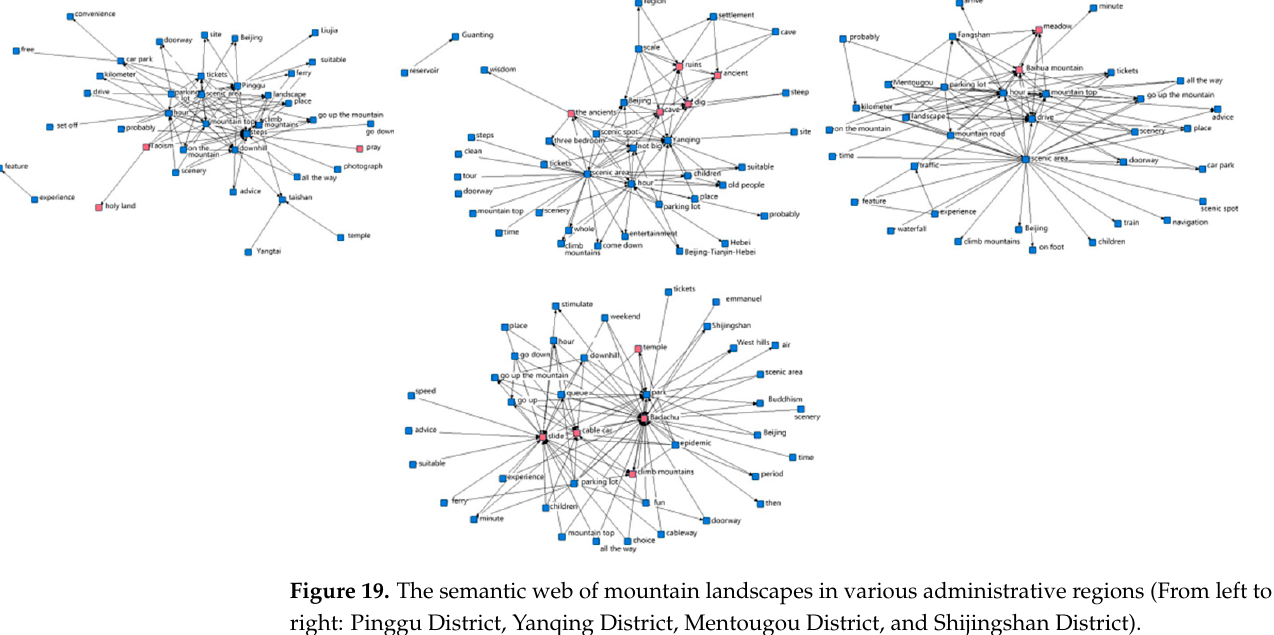
Figure 18. The semantic web of mountain landscapes in various administrative regions (From left to right: Haidian District, Huairou District, and Miyun District).